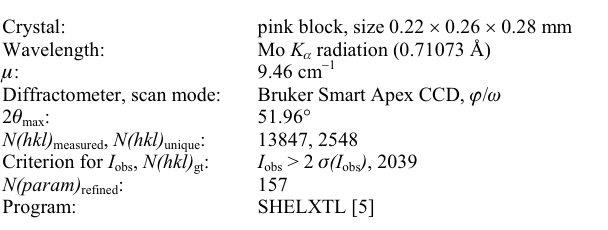
Table 1. Data collection and handling.